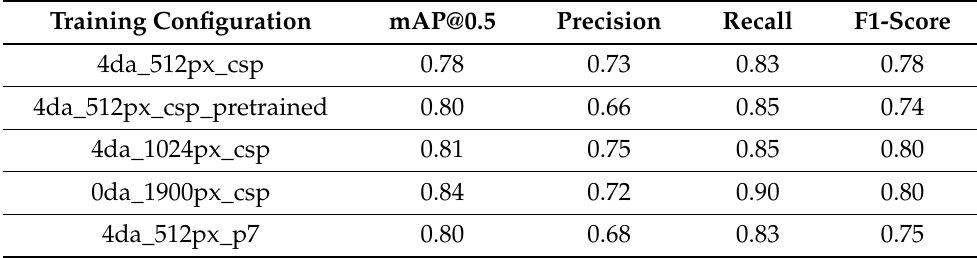
Table 4. Assessment results for the different training studies related with grapevine’ shoots detection and